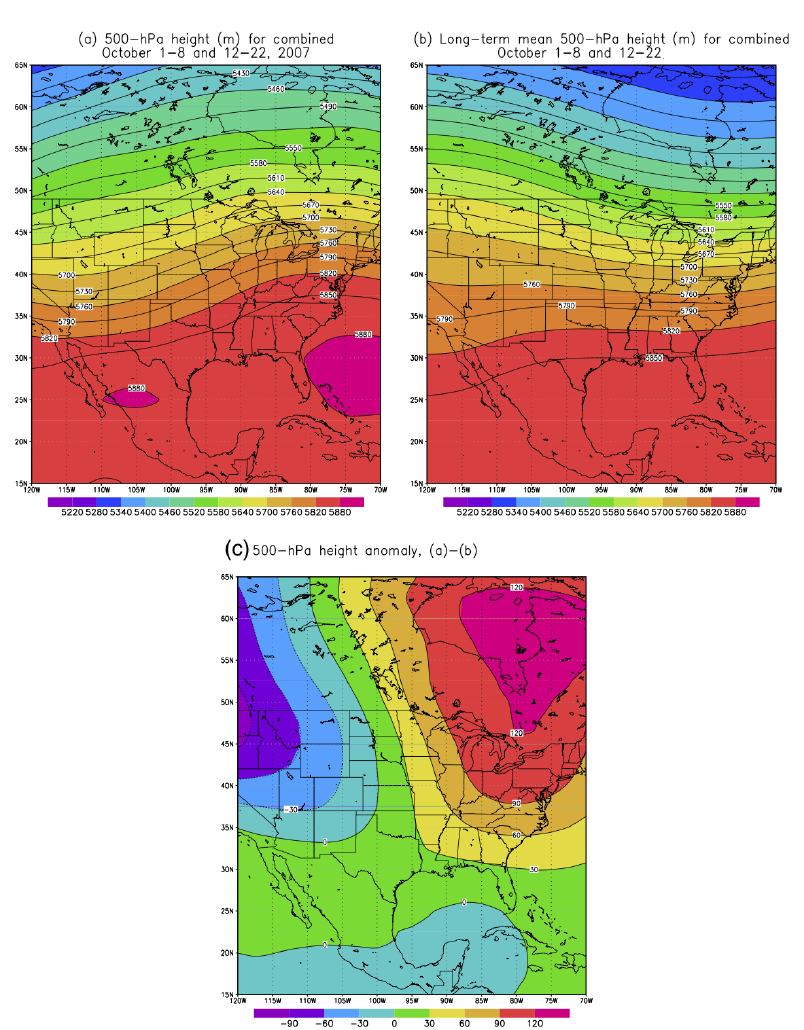
Figure 4. 500-mb geopotential height (in units of m) for the predefined sub-period of October 2007 in ( a ), for the long-term climatology in ( b ) and the anomaly in ( c